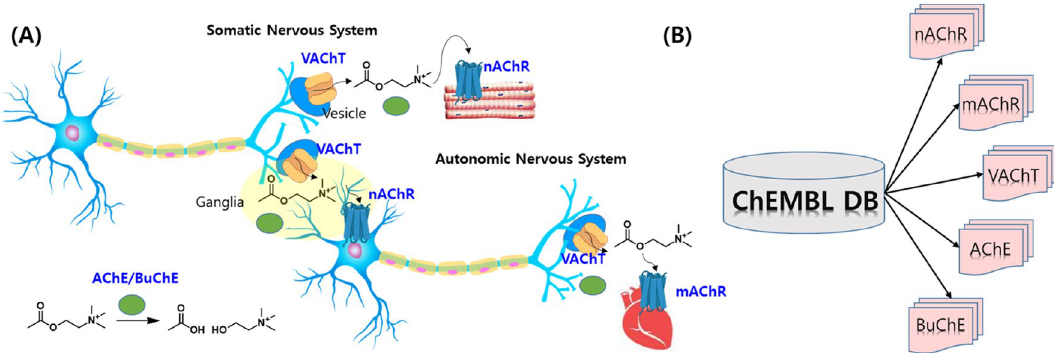
Figure 3. Description of cholinergic space in this study. ( A ) The location and roles of cholinergic targets in the nervous system. ( B ) Data collection of cholinergic agents from the ChEMBL database. All agents were extracted using respective cholinergic targets as MySQL queries. nAChR nicotinic acetylcholinesterase receptor, mAChR muscarinic acetylcholinesterase receptor, VAChT vesicular acetylcholine transporter, AChE acetylcholinesterase, BuChE butyrylcholinesterase.